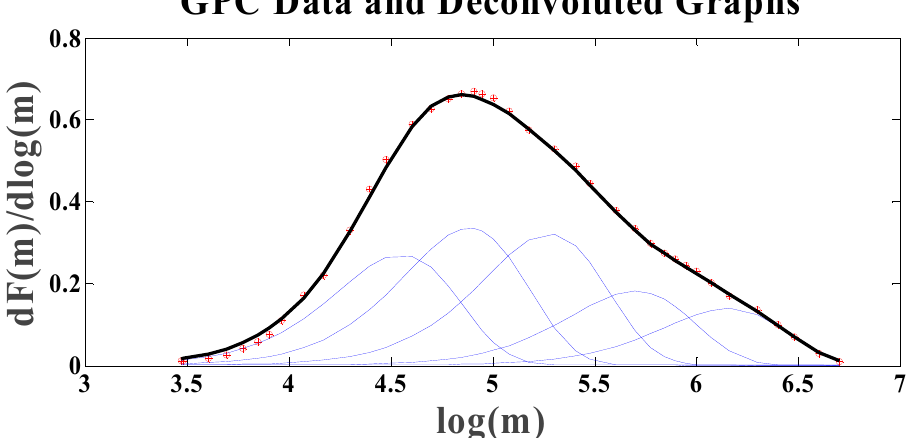
Figure 7. Deconvoluted GPC curve of a typically produced polypropylene.